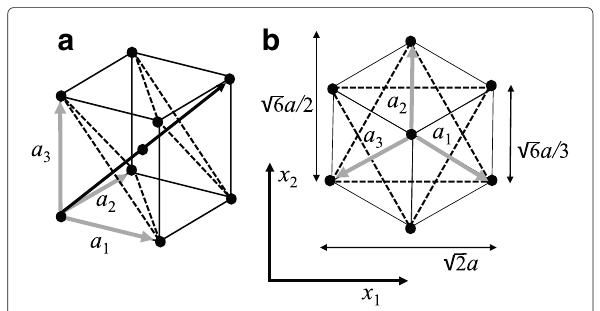
Fig. 6 Body centered cubic lattice and its projection along the ( 1,1,1 ) -direction. ( a ) shows the panoramic view of the unit cell of the BCC lattice which contains two triangles whose normal direction is ( 1,1,1 ) as in the simple cubic lattice case. Thus its projection along the ( 1,1,1 ) -direction is given by ( b )